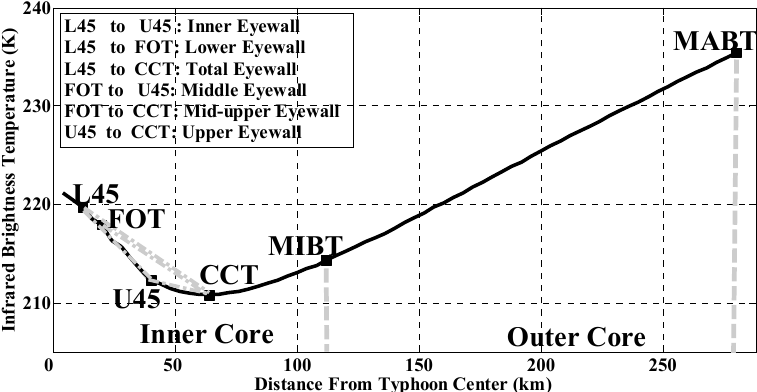
Figure 2. Schematic diagram of the radial profile (solid curve, calculated by averaging the radial profiles of the 16,126 images) of the IR brightness temperature. The vertical gray dashed line divides the core region into inner and outer core, respectively.